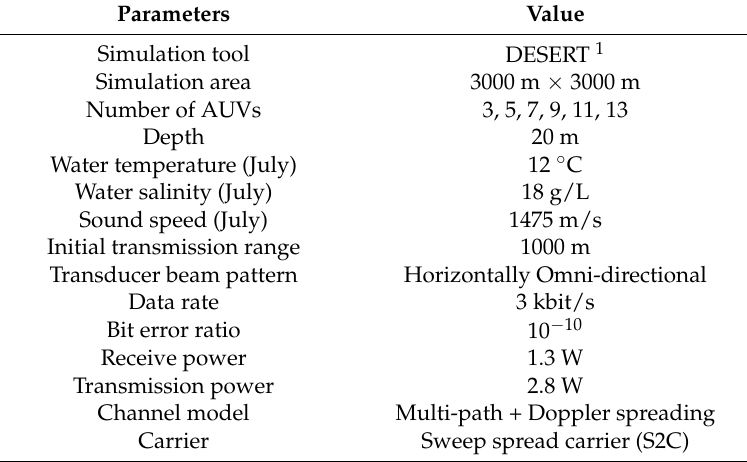
Table 4. Simulation configuration.